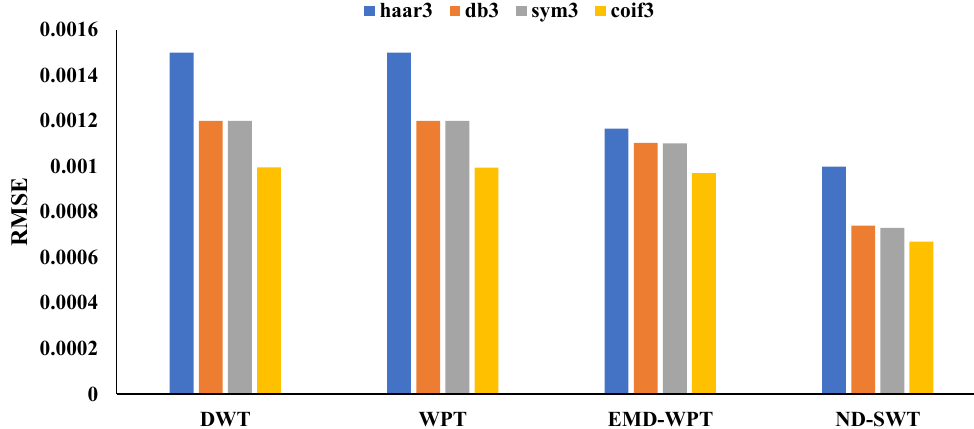
Figure 12. Comparison on RMSEs of the simulation AE signal with respect to four methods using four different